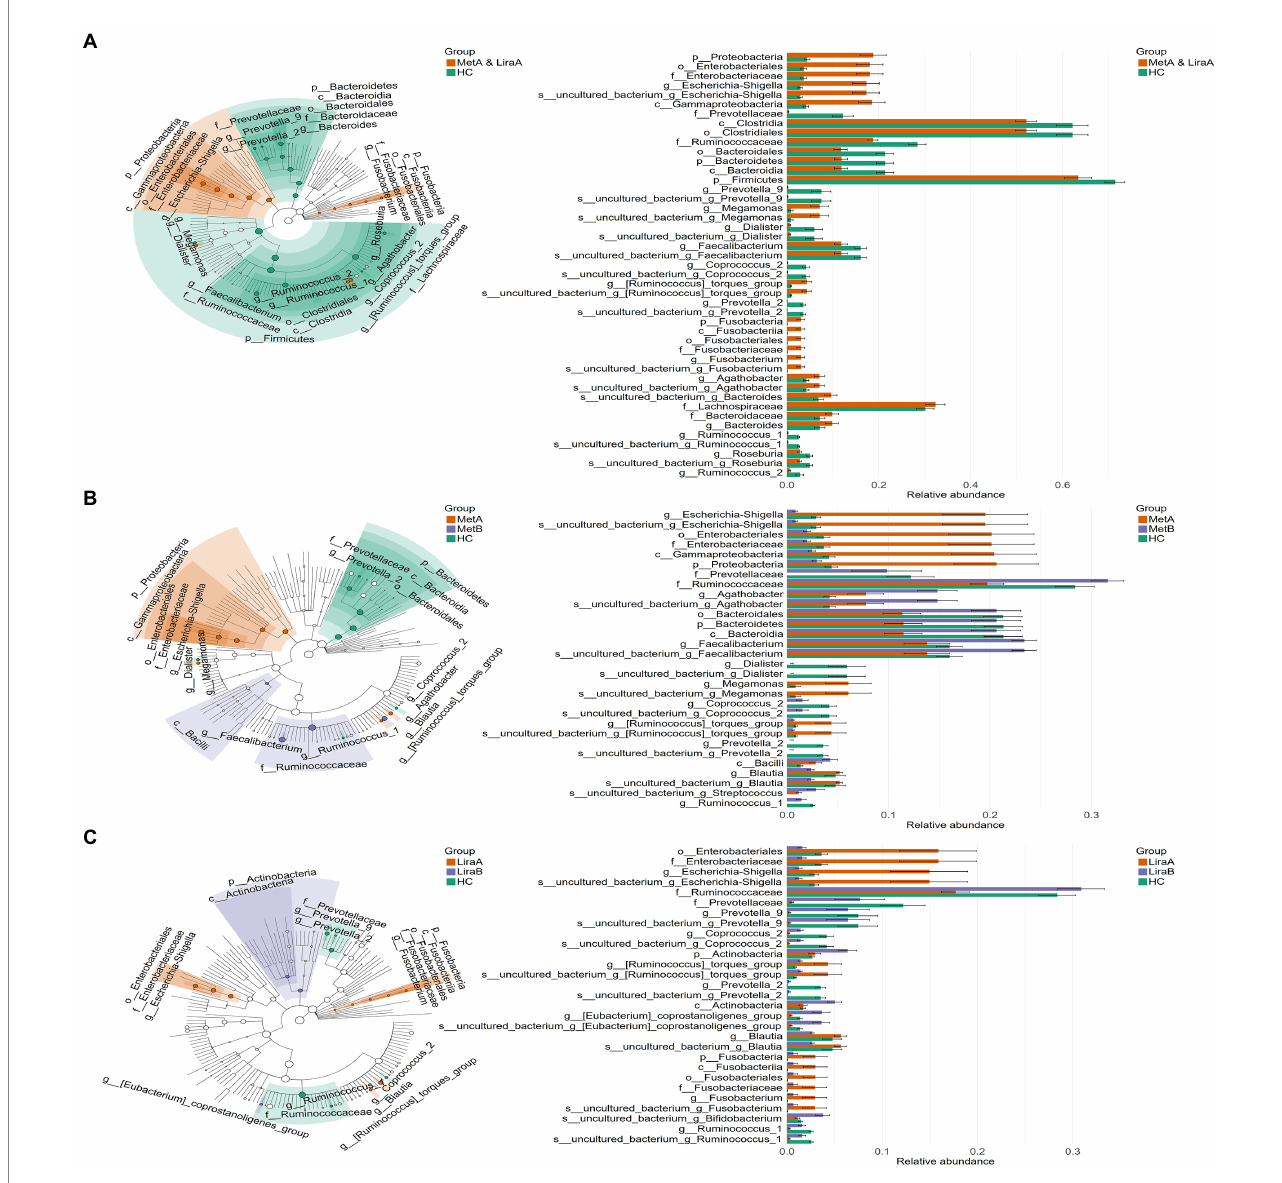
FIGURE 3 (A) Linear discriminant analysis effect size (LEfSe) of the intestinal bacterial community structure in healthy controls and patients before treatment (MetA & LiraA groups). (B) LEfSe of the intestinal bacterial community structure of patients before and after metformin treatment and healthy controls. (C) LEfSe of the intestinal bacterial community structure of patients before and after liraglutide treatment and healthy